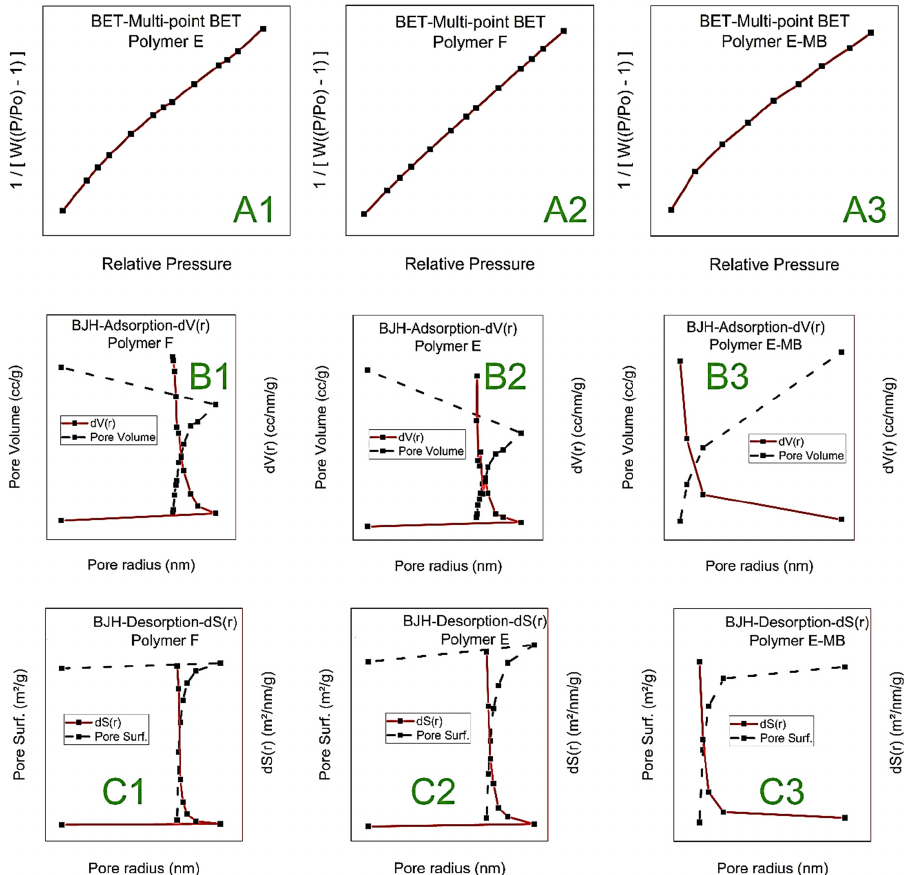
Figure 4. BET-Multi-point BET for polymer F ( A1 ), polymer E ( A2 ), and MB adsorbed on polymer E ( A3 ). BJH Pore Size Distribution-Adsorption for polymer F ( B1 ), polymer E ( B2 ), and MB adsorbed on polymer E ( B3 ). BJH Pore Size Distribution-Desorption for polymer F ( C1 ), polymer E ( C2 ), and MB adsorbed on polymer E ( C3 Table 2. Surface area, pore volume and radius of polymer F, polymer E, and MB adsorbed on poly- mer E.